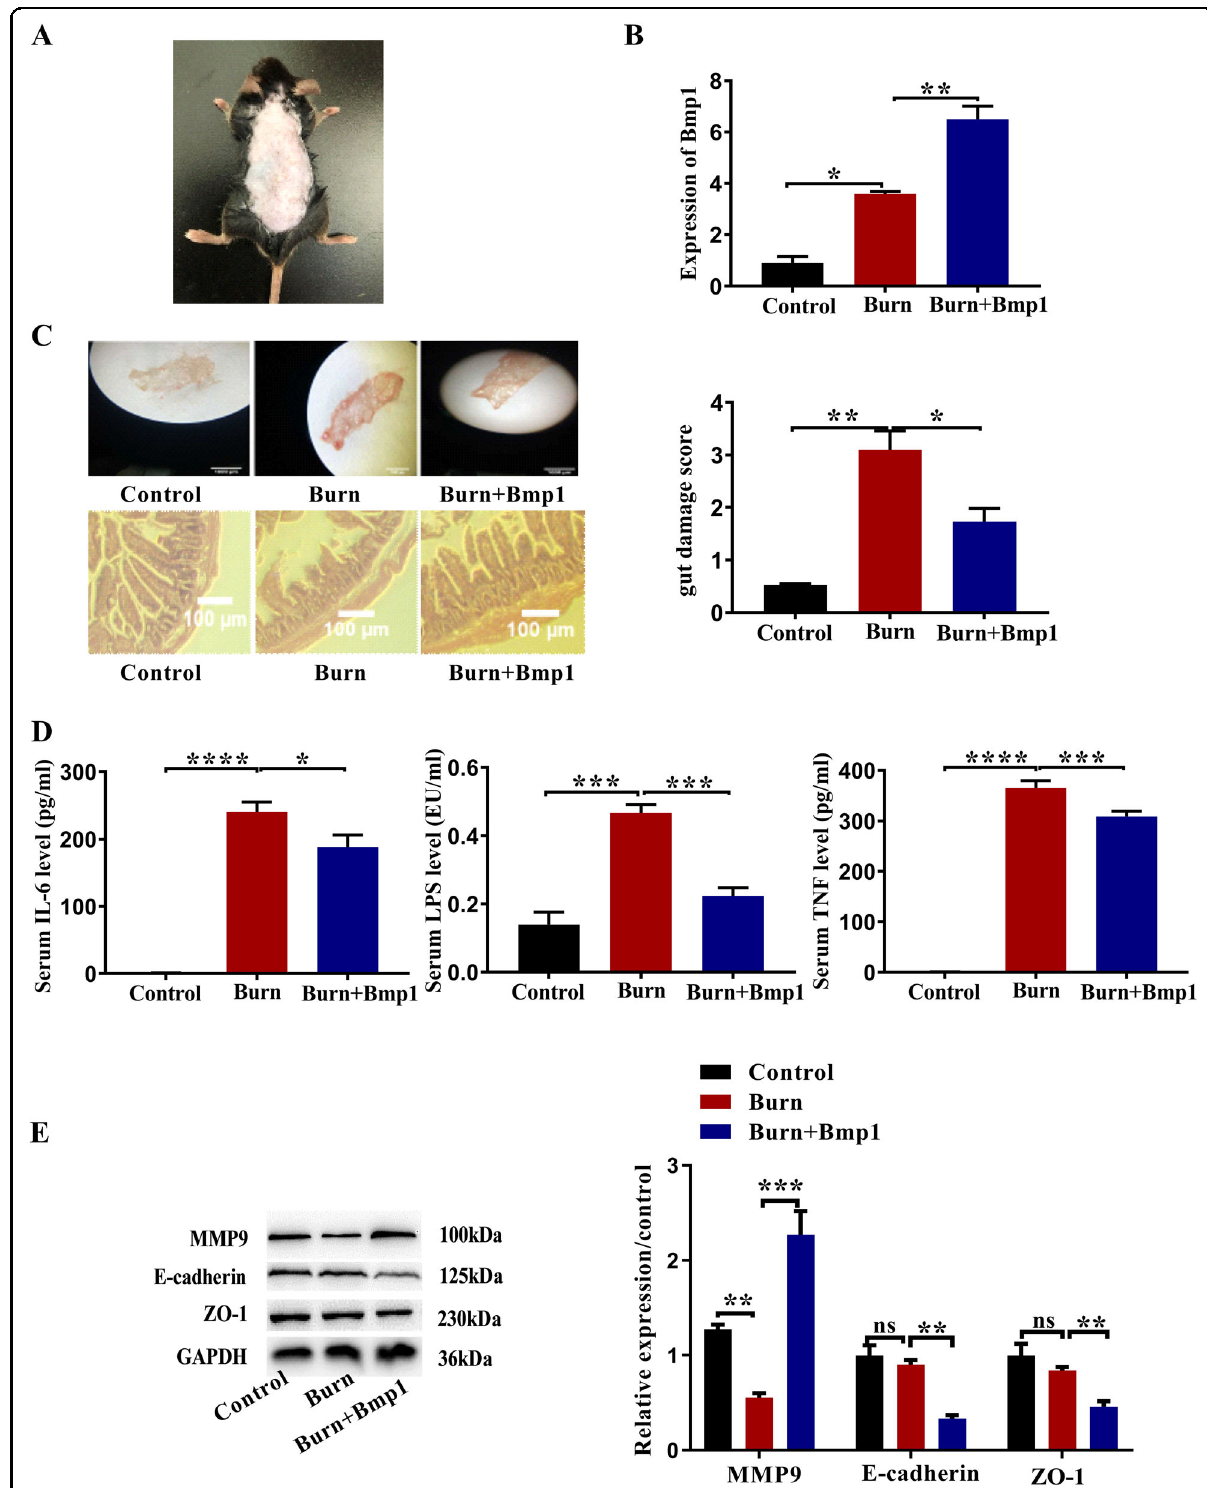
Fig. 3 Overexpression of Bmp1 reduces intestinal mucosal injury in burned mice. A The third-degree mouse burn model was established. B Expression of Bmp1 was determined by qRT-PCR ( n = 10). C Intestinal mucosa of burned mice were observed under a magnifying glass and intestinal mucosal injury scores were calculated by histological examination of H&E-stained sections under light microscopy ( n = 10). D TNF- α , IL-6, and LPS ( n = 10), E MMP9, E-cadherin, and ZO-1 were detected using ELISA and western blot, respectively ( n = 10). All data were demonstrated as mean±SD from three independent experiments performed in duplicate. * p <0.05, ** p <0.01, *** p <0.001 and **** p <0.0001 were all signi fi cant